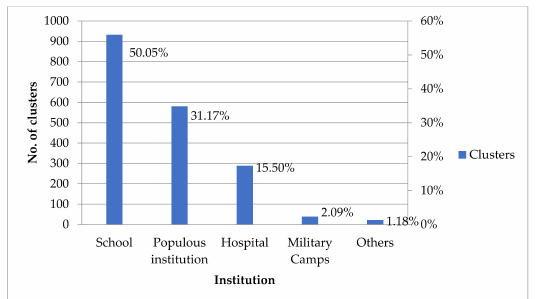
Figure 3. The number and percentage of institutions among URTI clusters, Taiwan, 2011–2019. URTI: upper respiratory tract